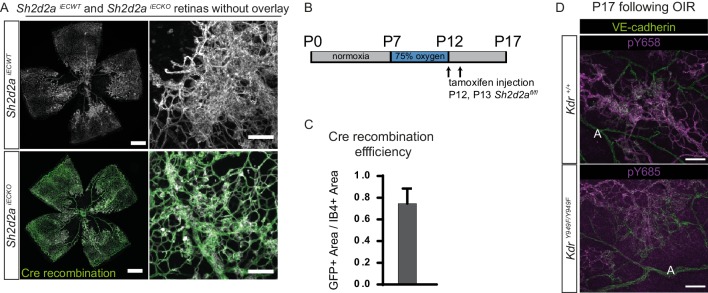
Retina vasculature following OIR in Shd2daiECKO and VE-cadherin phosphorylation in different vessel types.(A) Whole mount retinas from Shd2daiECKO and Sh2d2aiECWT mice, as shown in Figure 3 but displayed without overlays. Panels showing close up of tuft detail are placed to the right-hand side of each full retina image. Scale bar = 500 µm. Inset scale bar = 100 µm. (B) OIR timeline, showing the period of increased oxygen concentration with timing of tamoxifen administration given for the experiments on Shd2daiECKO and Sh2d2aiECWT mice. (C) Bar graph showing the observed Cre-induced recombination in Sh2d2afl/fl animals crossed with an mT/mG strain. Recombination calculated as the GFP fluorescent area divided by the IB4 positive total vascular area. (D) Kdr+/+ retinas, immunostained for VE-cadherin (green) and VE-cadherin pY658 (magenta; upper) or VE-cadherin pY685 (magenta;l ower) showing phosphorylation of VE-cadherin in capillaries and veins and increased staining in neovascular tufts. Scale bar = 25 µm. A, artery.